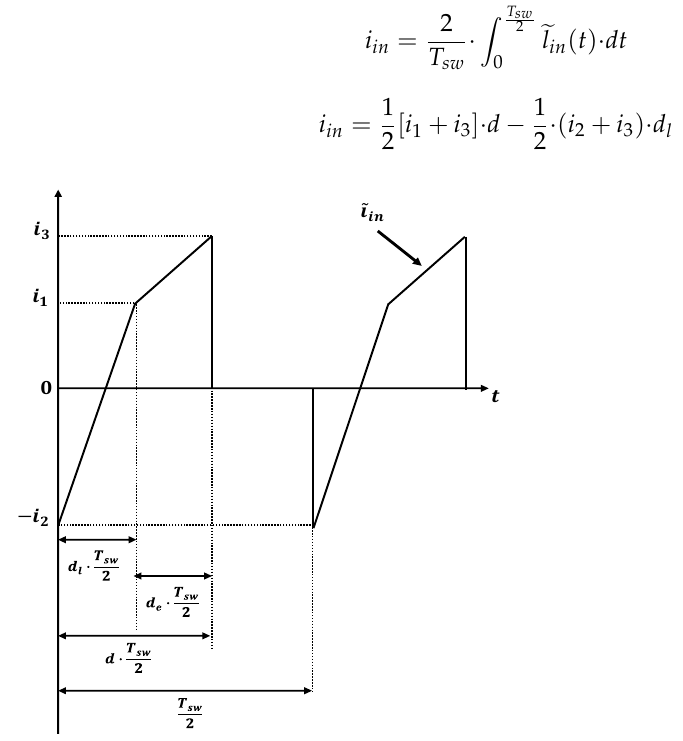
Figure 3. Input current waveform. The average model of the PSFB converter is shown in Figure 4.